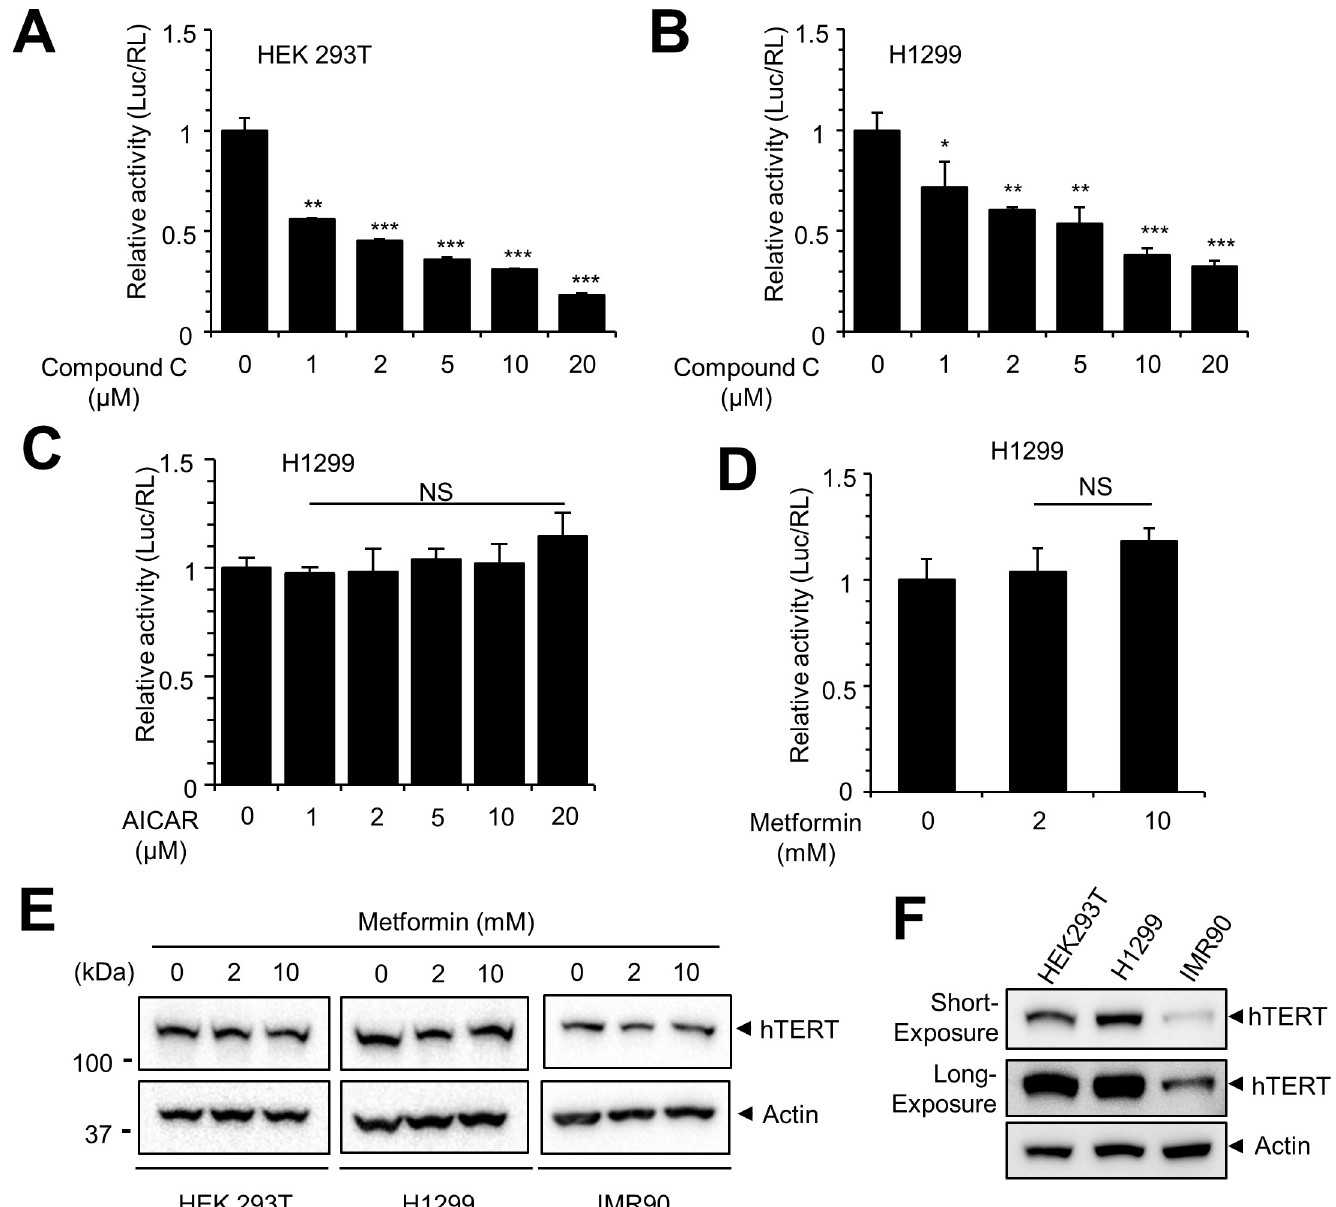
Fig 3. Compound C treatment decreases hTERT promoter activity, but AMPK activators do not increase the activity. ( A, B ) HEK293T and H1299 cells were transfected with hTERT-Luc plasmid. After 24 h after transfection, cells were treated with the indicated concentrations of compound C for 12 h, and the luciferase activity was measured. Relative luciferase activity was normalized to Renilla luciferase activity and is represented as a fold increase compared with the control. Control vs. drug treated, � P < 0.05, �� P < 0.005 ��� P < 0.001. ( C, D ) H1299 cells were transfected with hTERT-Luc plasmid. Cells were treated with the indicated concentrations of AICAR and metformin for 12 h, and the luciferase activity was measured. Relative luciferase activity was normalized to Renilla luciferase activity and is represented as a fold increase compared with the control. ( E ) HEK293T, H1299 and IMR90 cells were treated with the indicated concentration of metformin for 12 h, and the expression of hTERT protein was examined by Western blot. ( F ) Expression of endogenous hTERT protein in HEK293T, H1299 and IMR90. Equal amount of cell lysates were subjected to Western blot with the indicated